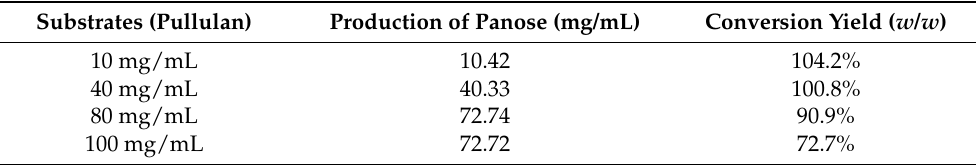
Table 2. HPLC–ELSD analysis of hydrolysis products from the different concentration of pullulan by